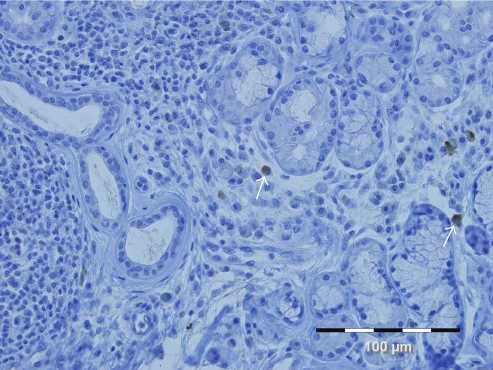
Figure 1: Infiltration of IgG-positive plasma cells in LSGB of patients with SS. Sections of LSGB were immunostained with hema- toxylin and eosin (H&E) and anti-IgG antibodies. Diaminobenzi- dine (in brown on the picture showed by white arrows) was used as the reagent to visualize the antigenic sites.